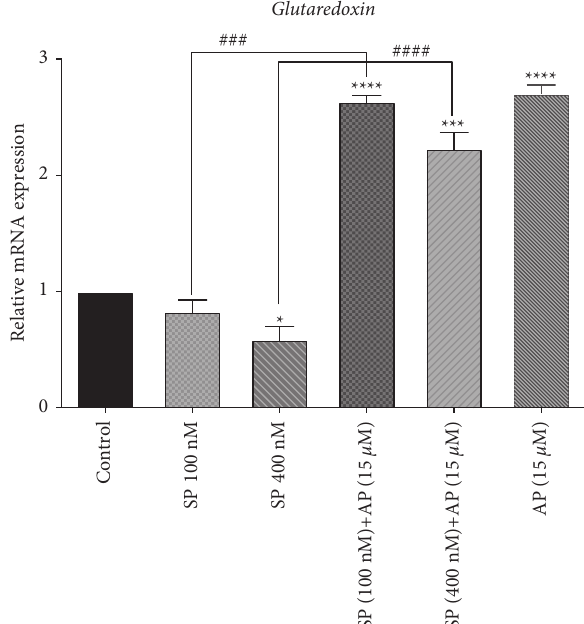
Figure 3: The effects of SP and aprepitant on the mRNA expression level of glutaredoxin in U87 glioblastoma cells. The results dem- onstrate that mRNA expression of glutaredoxin is significantly increased in cells treated with aprepitant (15 μ M) with or without pretreatment with SP (100 and 400nM) as compared to the un- treated control cells. The level of expression of glutaredoxin was normalized by GAPDH mRNA levels and indicated as mean ± SD ( p < 0 . 05).